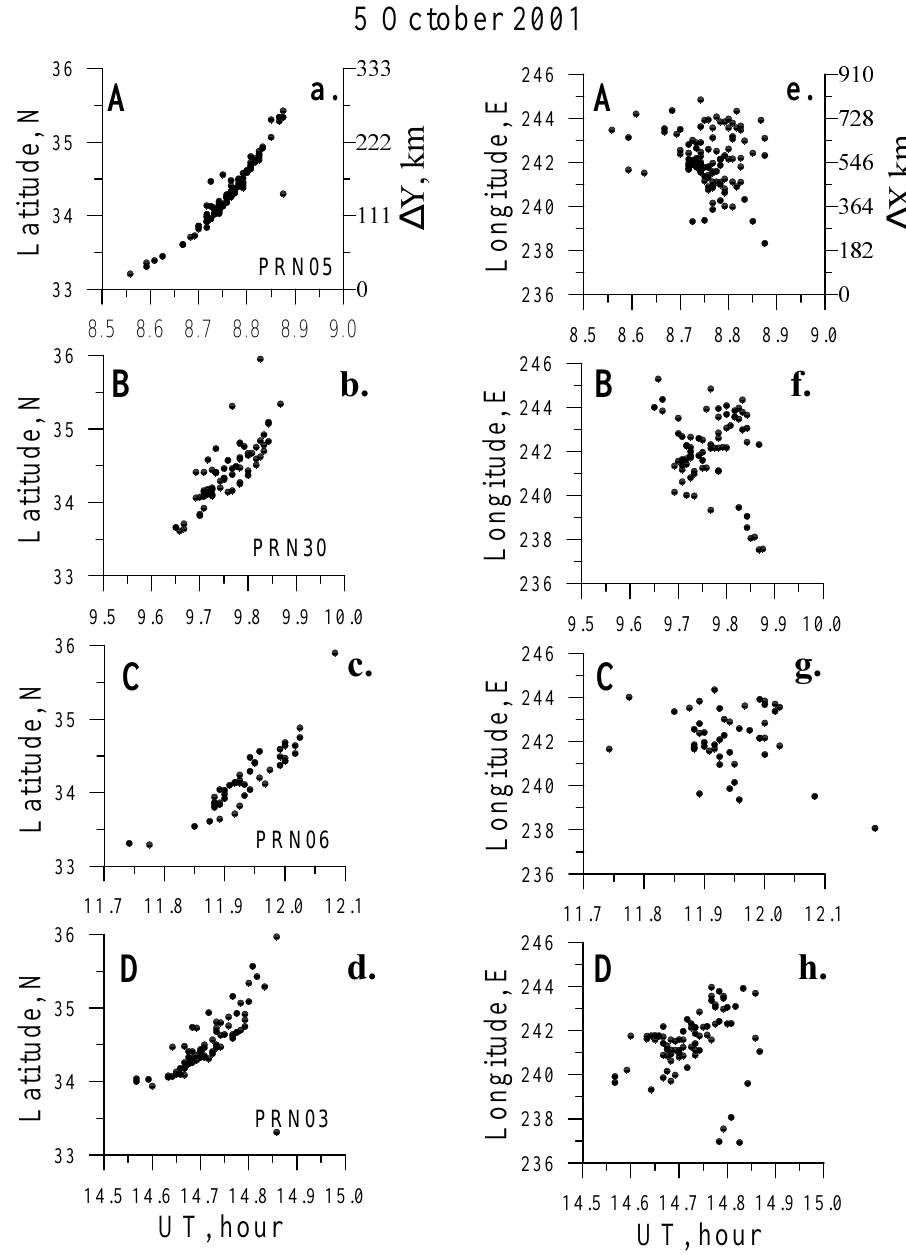
Fig. 6. (a), (c), (e), (g) – The distribution of the values of the GPS station latitudes from time t min , corresponding to each of the TECS detected that day; the letters A, B, C and D label the TECS “traces” that are presented in Fig. 5 on a longer time scale; (b), (d), (f), (h) – same as in Fig. 8a, c, e, and g, but for the station longitudes and t min . The right scales on panels (a) and (e) shows the relative linear coordinates 1X and 1Y in topocentric frame of